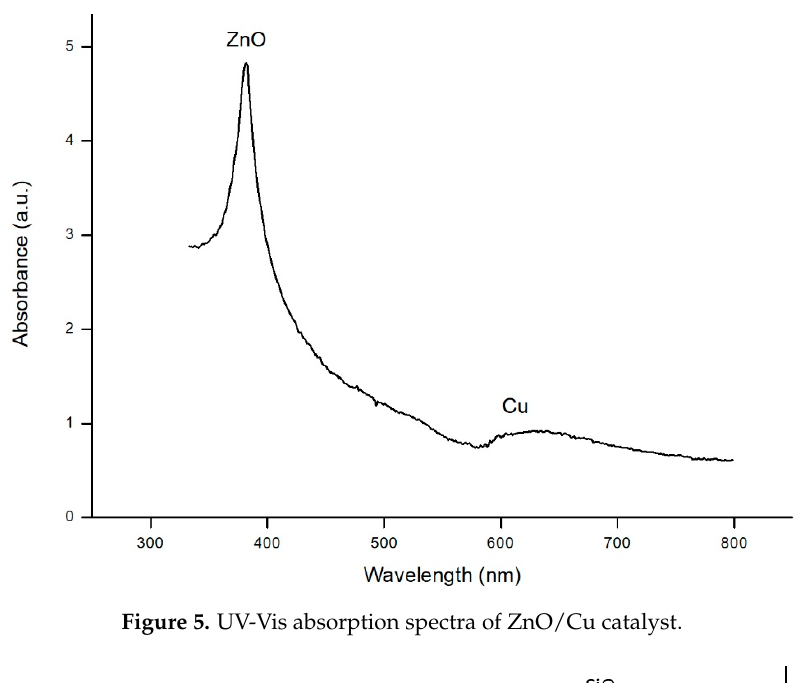
Figure 5. UV-Vis absorption spectra of ZnO/Cu catalyst.